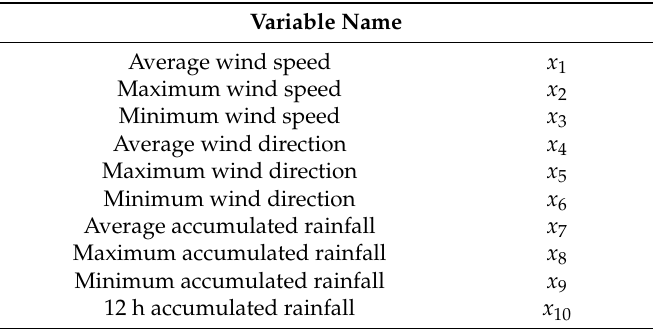
Table 2. Available explanatory